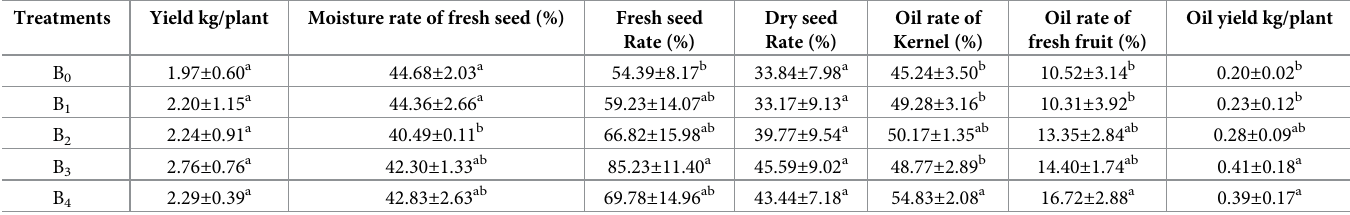
Table 2. Effects of biogas slurry on yield and the main properties of C . oleifera . Treatments